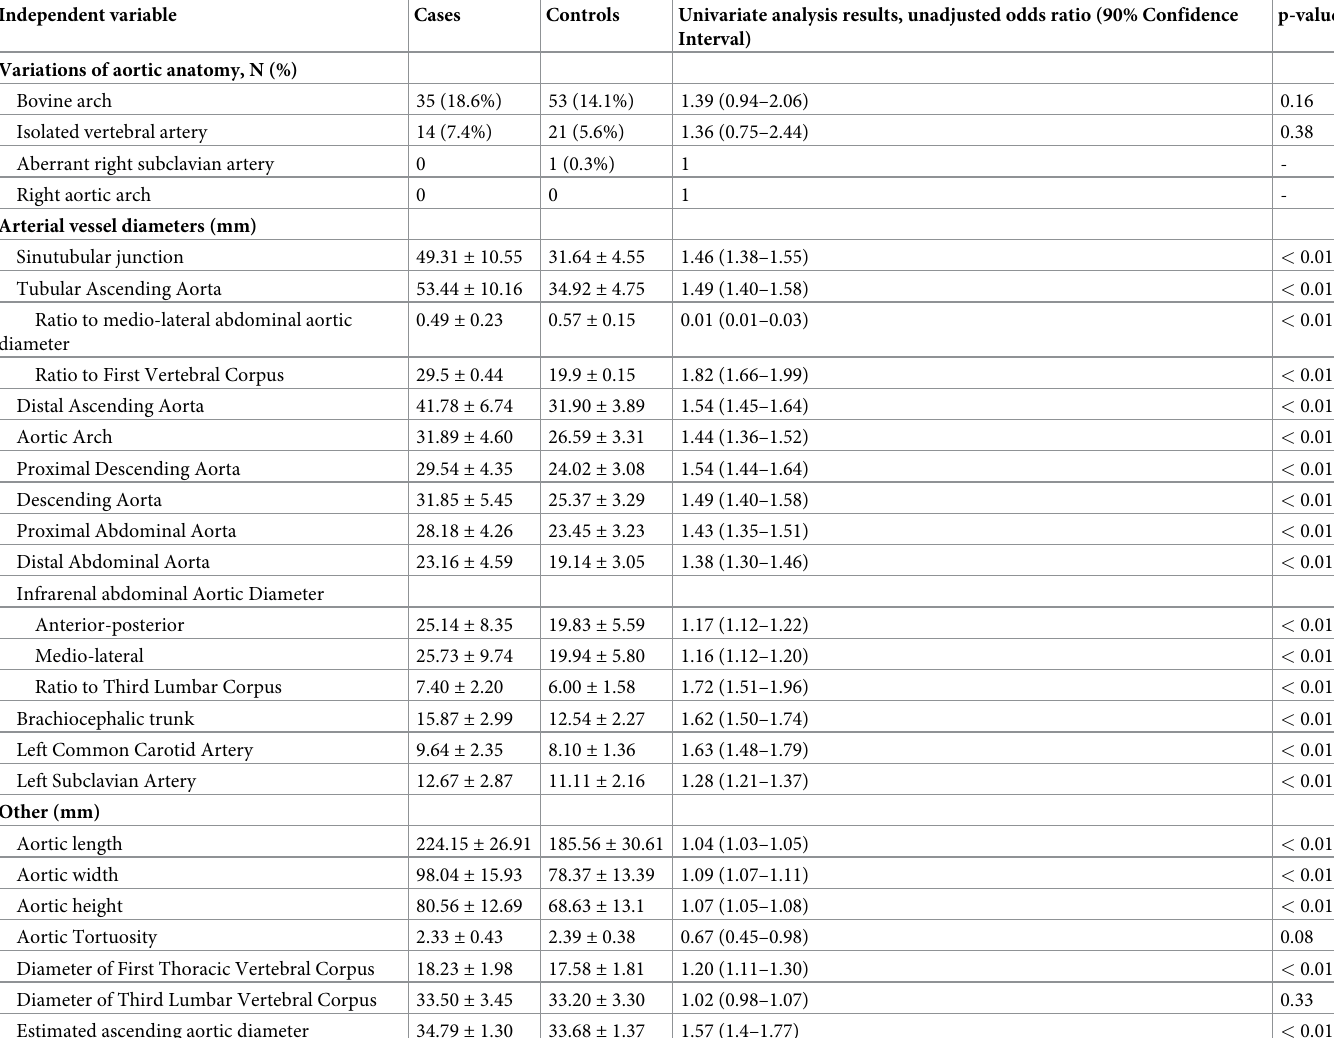
Table 2. Descriptive statistics of independent variables, gathered through analysis of computer tomography scans, and results of univariate logistic regression anal- ysis where the presence of acute or chronic aortic syndrome of the ascending aorta is the dependent variable. Continuous variables are presented with mean ± standard deviation, categorical variables with numbers and frequency. “- “= no results due to no/low